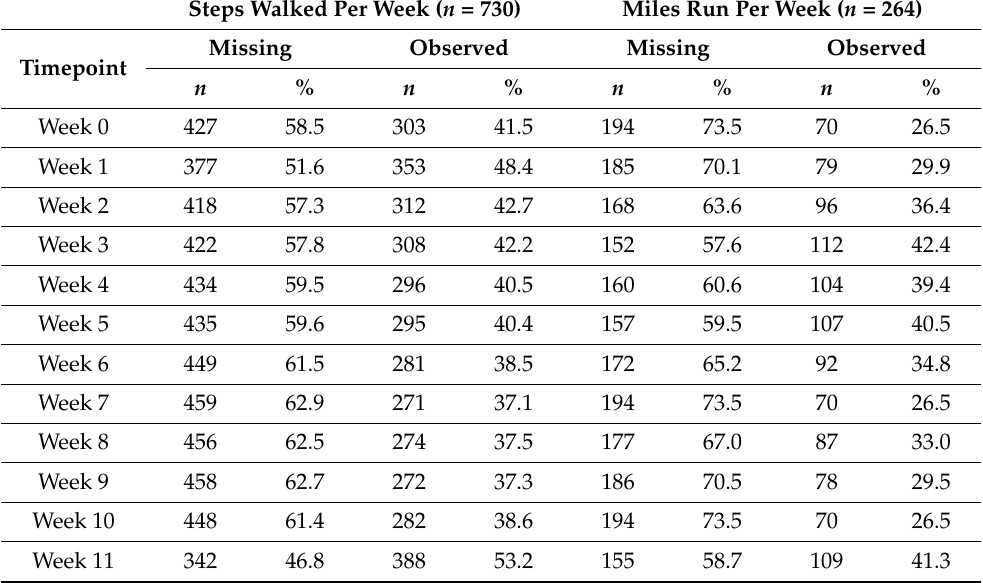
Table A1. Availability of PA data at each